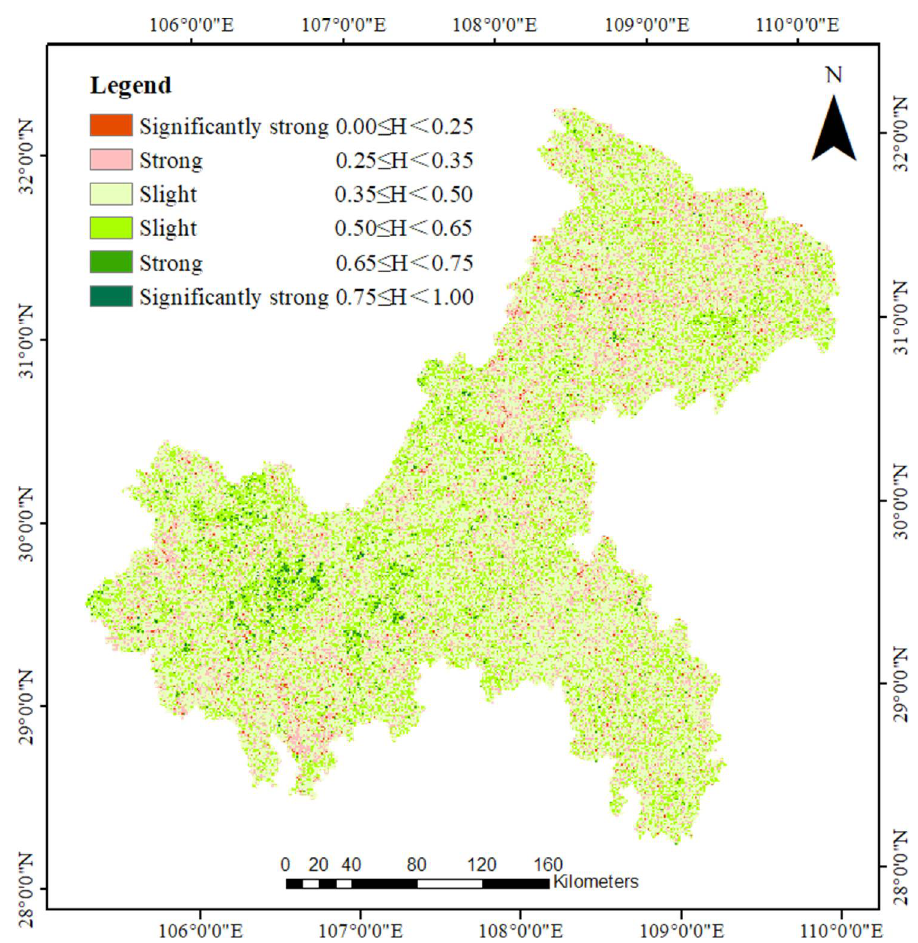
Figure 13. Spatial distribution of the Hurst index from 2000–2020.